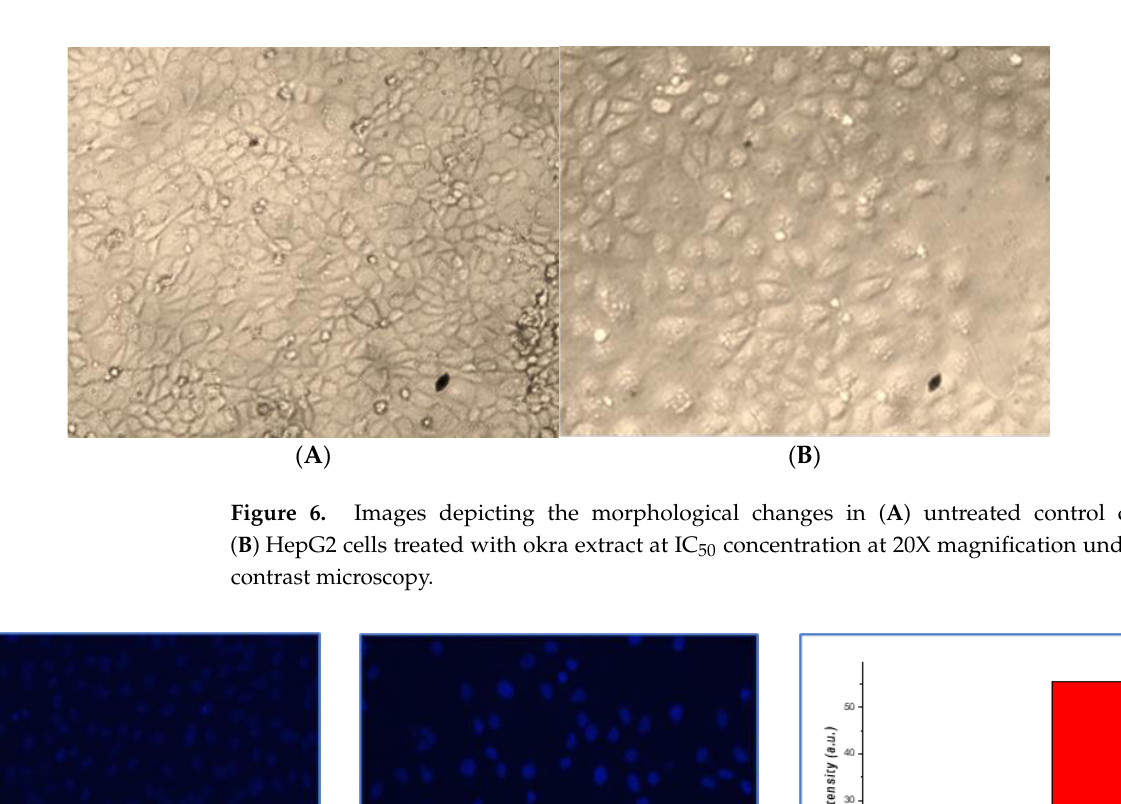
Figure 6. Images depicting the morphological changes in ( A ) untreated control cells and ( B ) HepG2 cells treated with okra extract at IC 50 concentration at 20X magnification under phase-con- trast microscopy.